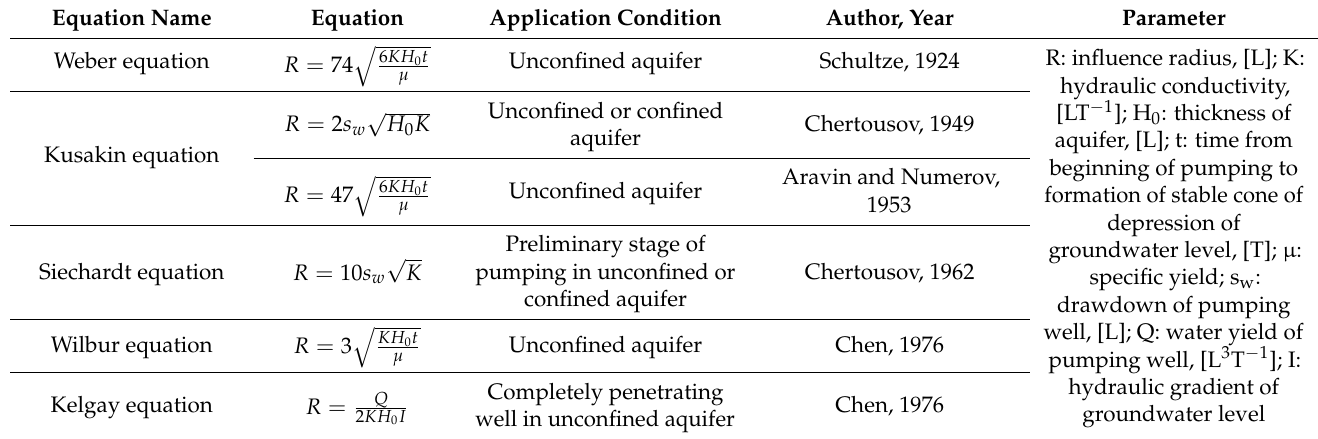
Table 1. Equations for calculating the influence